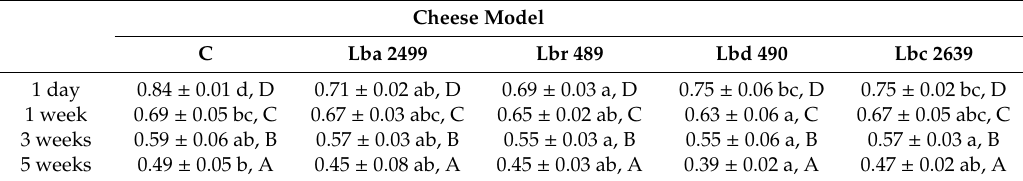
Table 1. IC 50 values of ACE-inhibitory activity from control cheese models and with adjunct culture (mg mL − 1